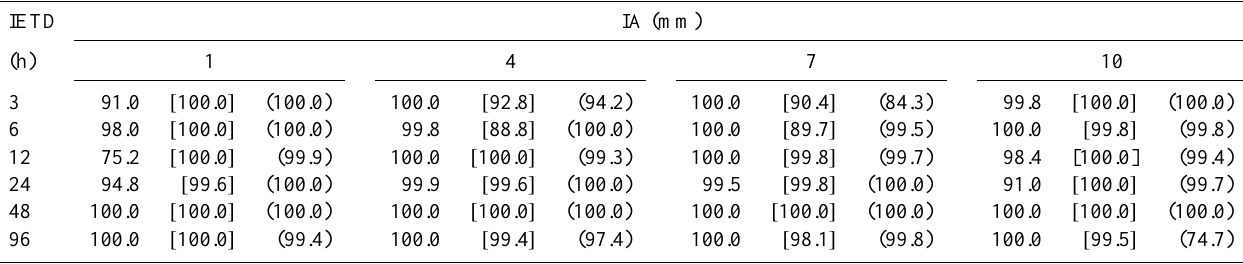
Table 5. p -values (%) obtained when testing the independence between the event volume and the interevent dry period for the rainfall series of Brescia, Parma [.], and Naples (.).